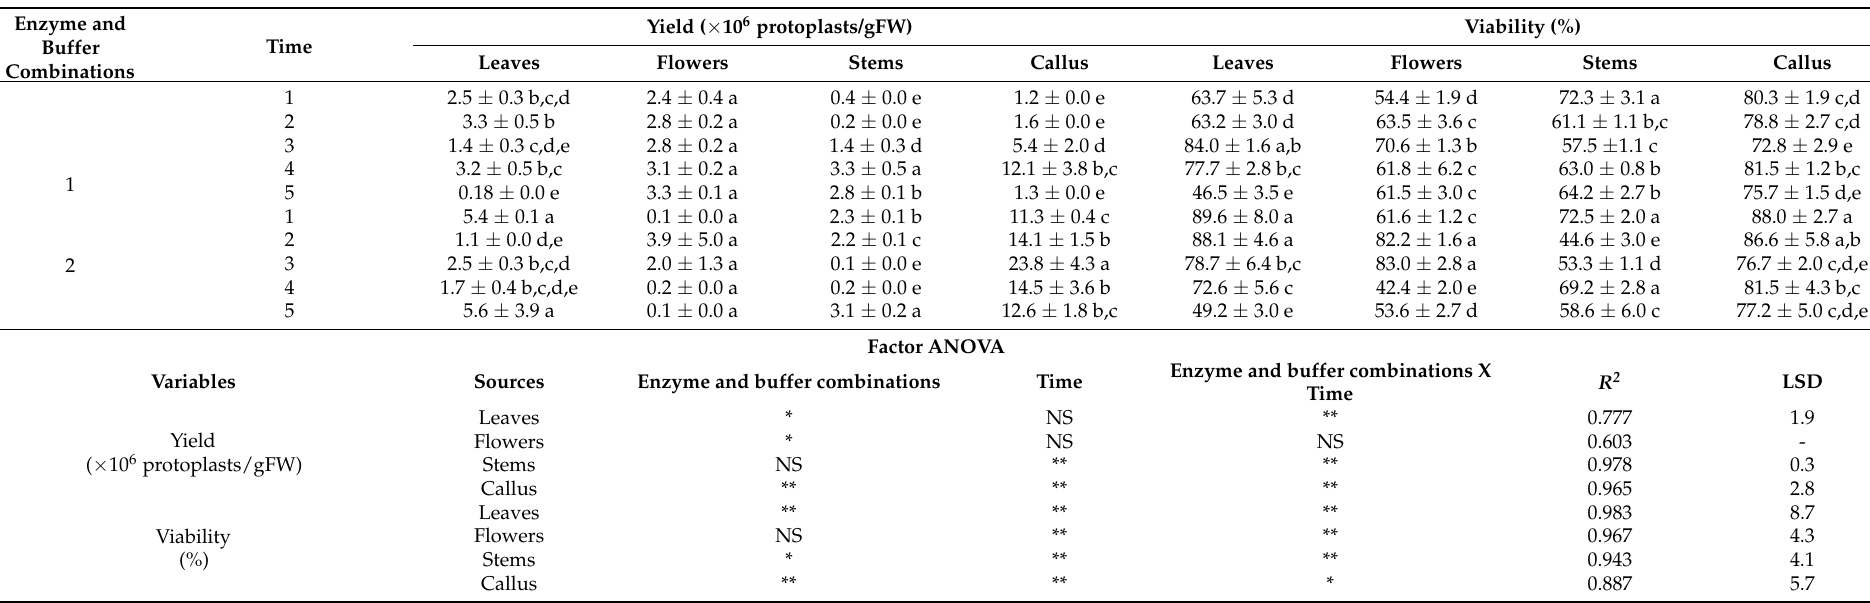
Table 3. Protoplast yield and viability of isolated protoplast from leaves, flowers, stems and callus of J. sambac L. using different enzyme solutions. Enzyme and